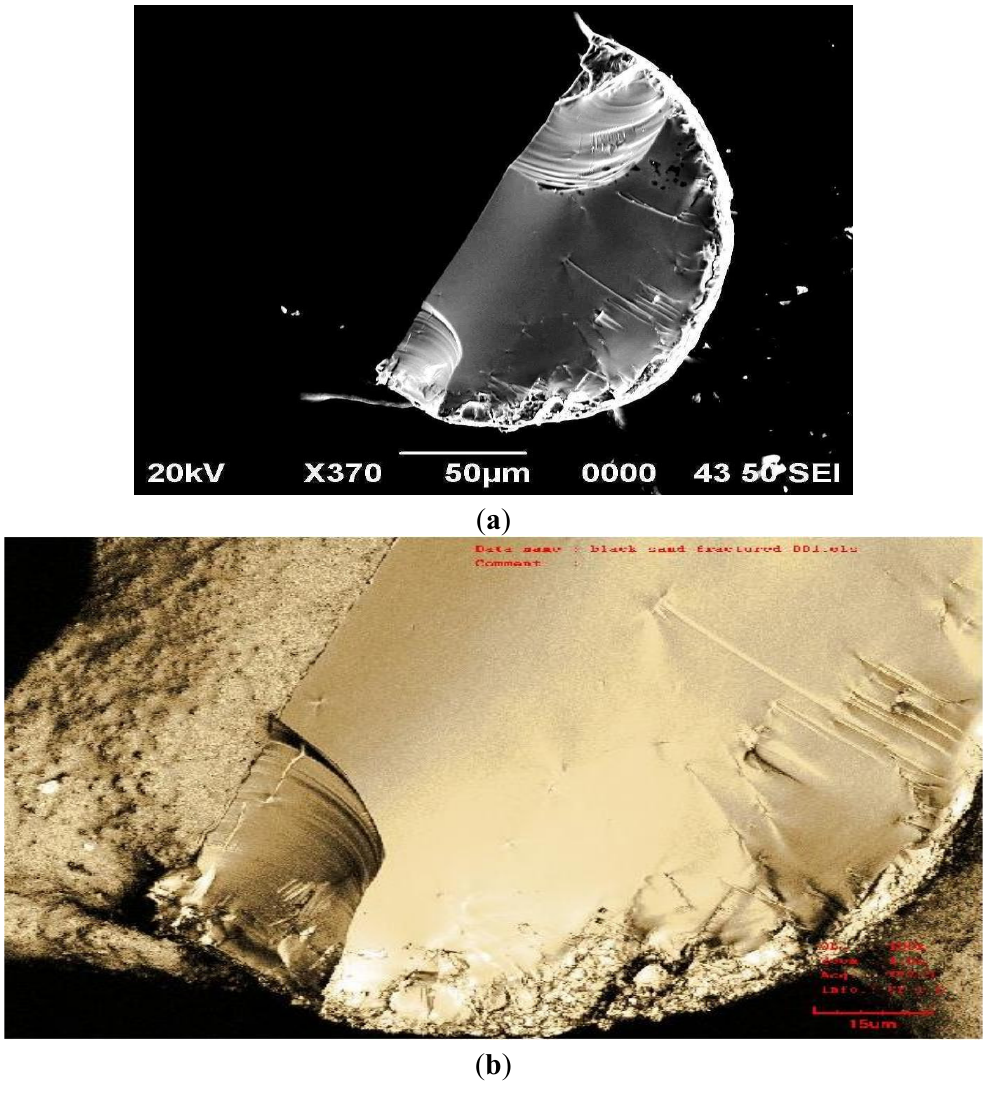
Figure 6. ( a ) Scanning electron micrograph of magnetic black sand (370× magnification); ( b ) LSM image of magnetic black sand (100×